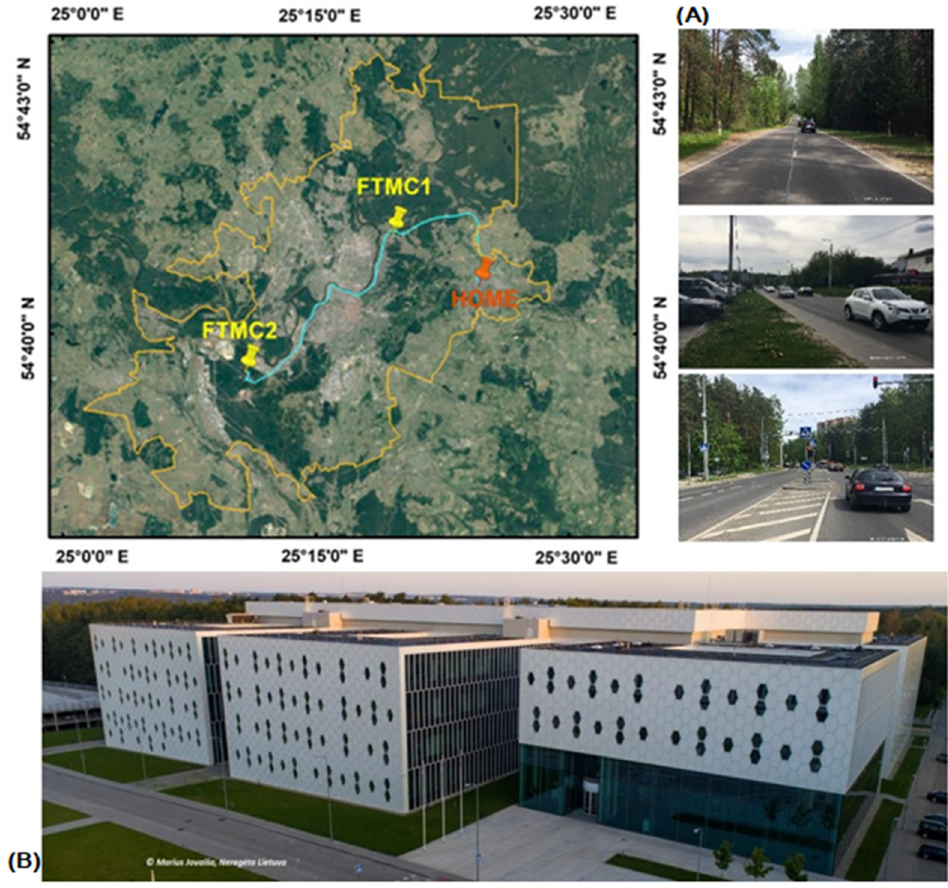
Figure 1. Mobile monitoring routes with points representing the place of residence (red pin) and the workplace (FTMC1 and FTMC2, yellow pins) ( A ); street ( B ) and office (FTMC1). The fixed measurement location (urban background) coincides with the location of FTMC1.